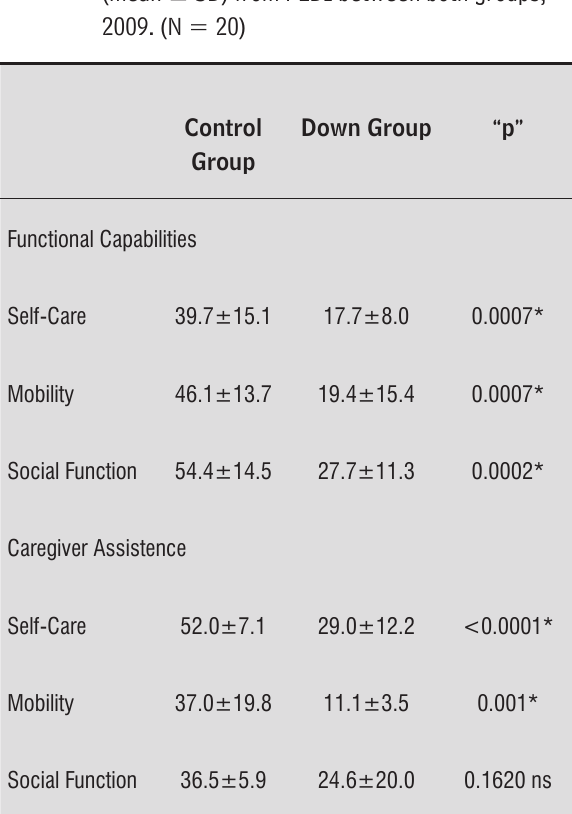
Table 1 - Distribution of age and normative score values (mean ± SD) from PEDI between both groups, 2009. (N = 20)